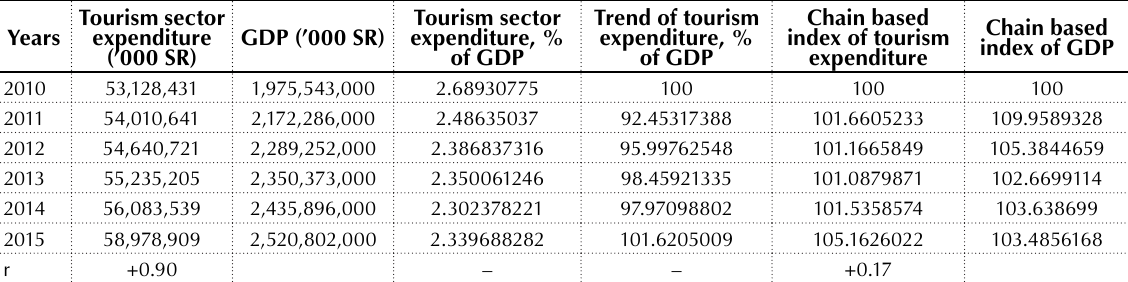
Source: General Authority for Statistics and GDP from SAMA